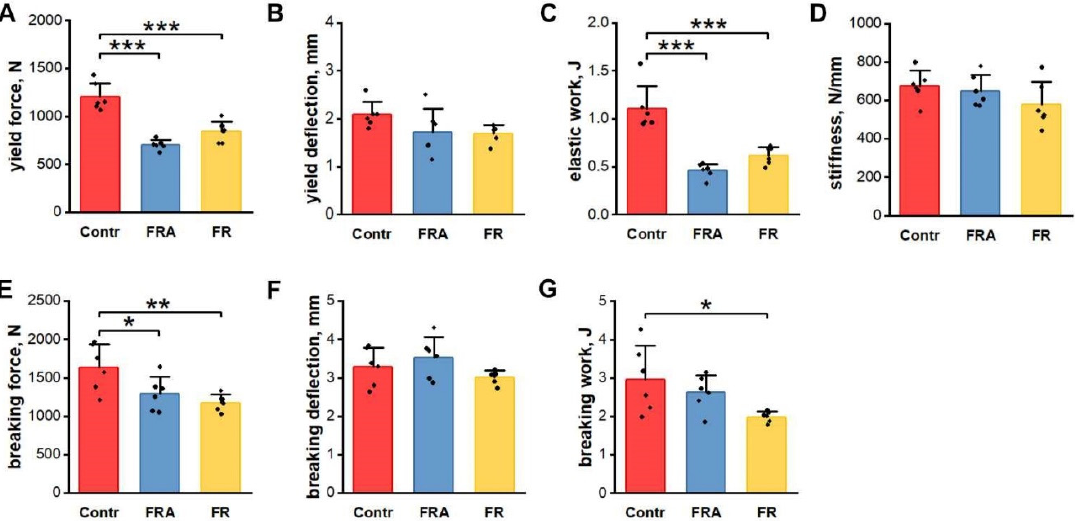
Figure 3. Mechanical properties of bone mid-diaphysis of femurs of animals in experimental groups. ( A ) yield force, ( B ) yield deflection, ( C ) elastic work, ( D ) stiffness, ( E ) breaking force, ( F ) breaking deflection, ( G ) breaking work. Bar plots show mean values and standard errors. A range of p -values has been assigned above plots where two groups show significant differences: * p < 0.05, ** p < 0.01, *** p < 0.001.